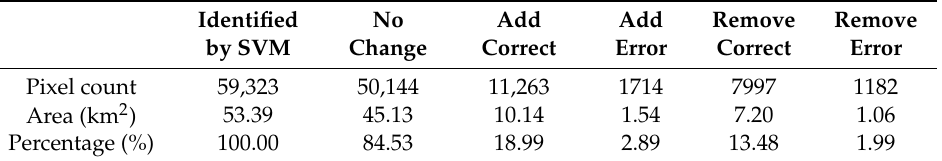
Table 3. Changes in impervious surface after integration based on the sub-image.